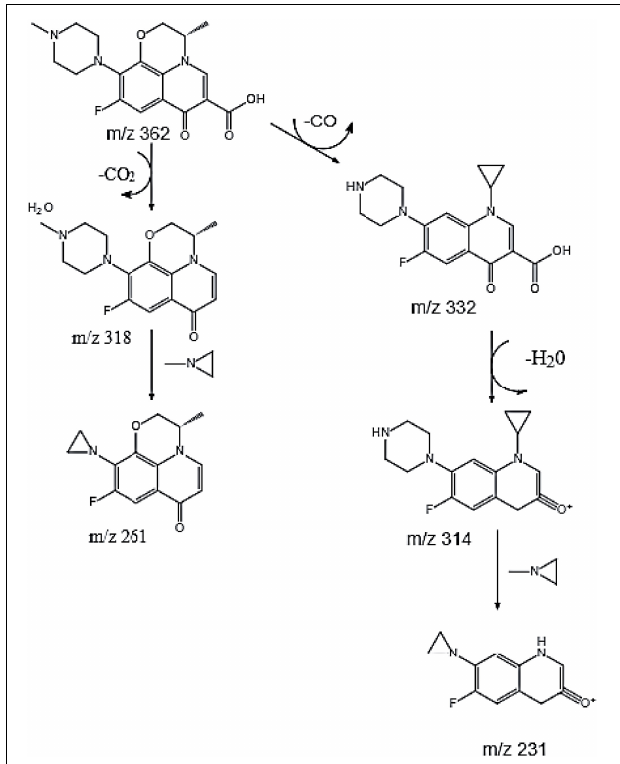
FIGURE 4 | Possible degradation pathways of OFL.